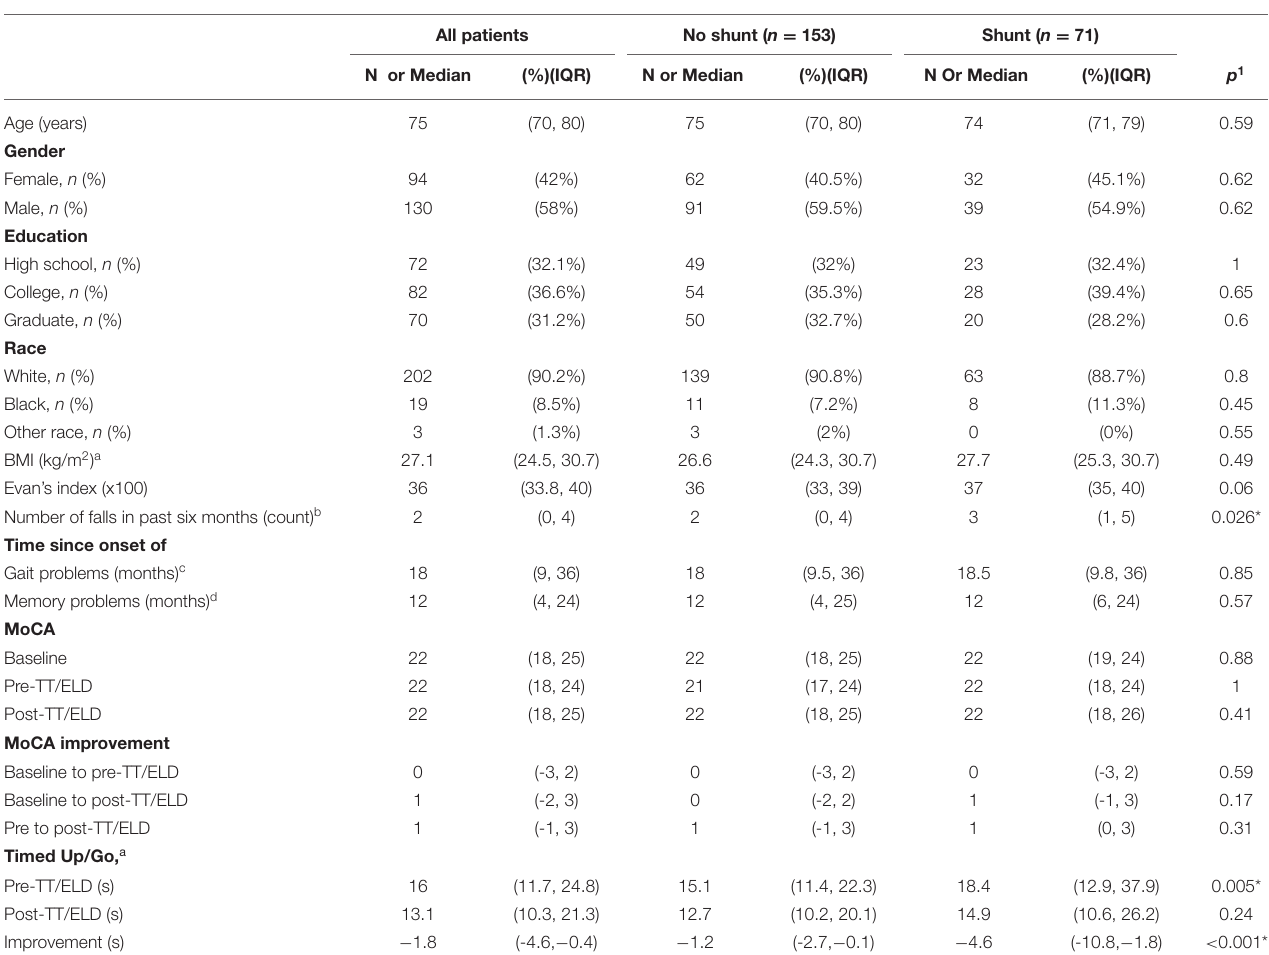
TABLE 1 | Patient characteristics by diagnosis of normal pressure hydrocephalus ( n =